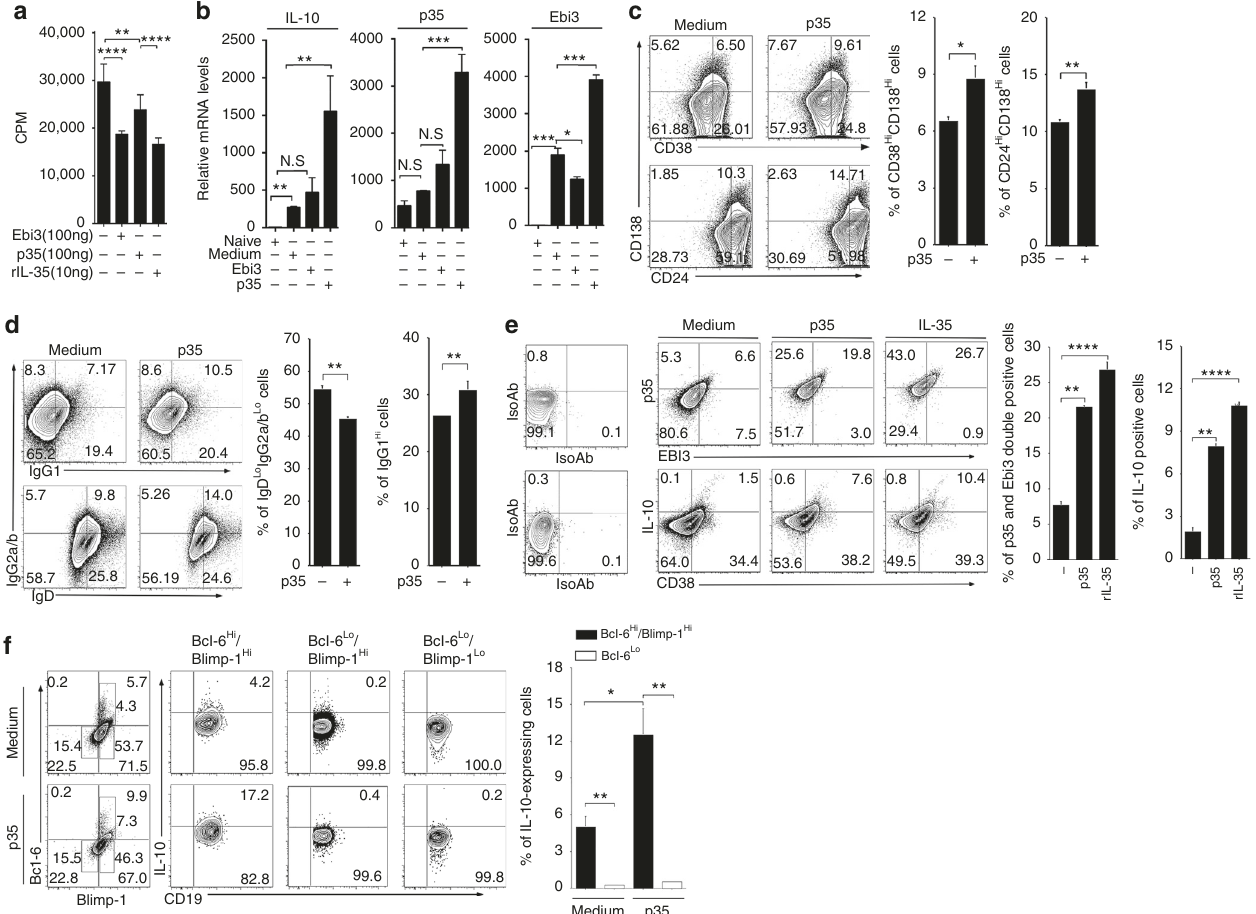
Fig. 5 p35 induced expansion of IL-10- and IL-35-expressing B cells. a Primary mouse CD4 + T cells were stimulated for 3 days with anti-CD3/anti-CD28 in medium containing rEbi3, p35, or rIL-35 and proliferative capacity of the cells was assessed by [ 3 H]-thymidine incorporation assay. b CD19 + B cells were activated with LPS in the absence or presence of p35 or rEBi3 and analyzed by qRT-PCR. c – f Puri fi ed primary mouse CD19 + B cells were activated with LPS in the absence or presence of p35 and analyzed by FACS. The numbers in the quadrants indicate the percentages of IgG + , IgD + , CD138 + , CD38 + , and/or CD24 + B cells. d – f CD19 + B cells were activated with LPS in the absence or presence of p35 or rIL-35 and analyzed by the intracellular cytokine-staining assay for detection of B cells expressing IgG1, IgG2a/b, IL-12p35, Ebi3, Bcl-6, and Blimp-1 as indicated on the fi gures. Results represent at least three independent experiments and were analyzed using Student ’ s t -test (two-tailed). Data are mean ± SEM (* P < 0.05; ** P < 0.01; *** P < 0.001; **** P <